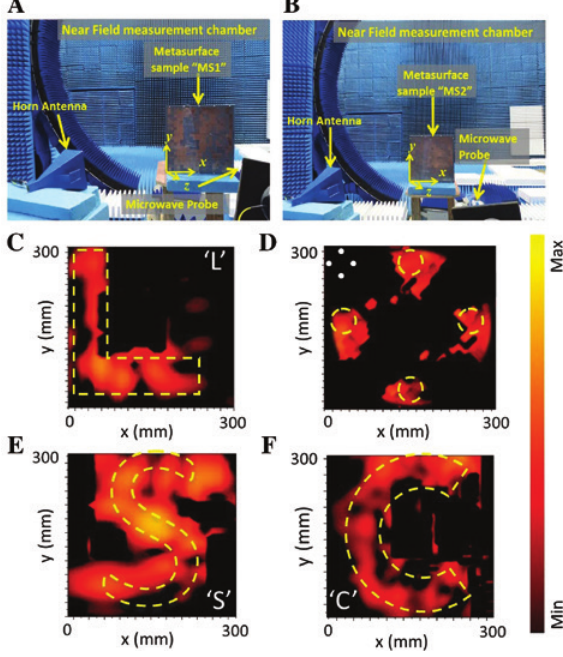
Figure 8: Measurement setup. The measurement setup for extracting the low-frequency and high-frequency holographic images of two fabricated coding meta- holograms of (A) MS1 and (B) MS2 in an anechoic chamber that includes a horn antenna, a standard microwave probe as a receiver, and a vector network analyzer. (C)–(F) Experimental results for the holographic images of “L”/four disordered hotspots and “S”/“C”, letters in the reflection side. The measured field intensities of the fabricated meta-holograms (C), (D) MS1 and (E), (F) MS2 at the (C), (E) low-frequency (10 GHz) and (D), (F) high-frequency (15 GHz) near- field channels illustrated in Figure